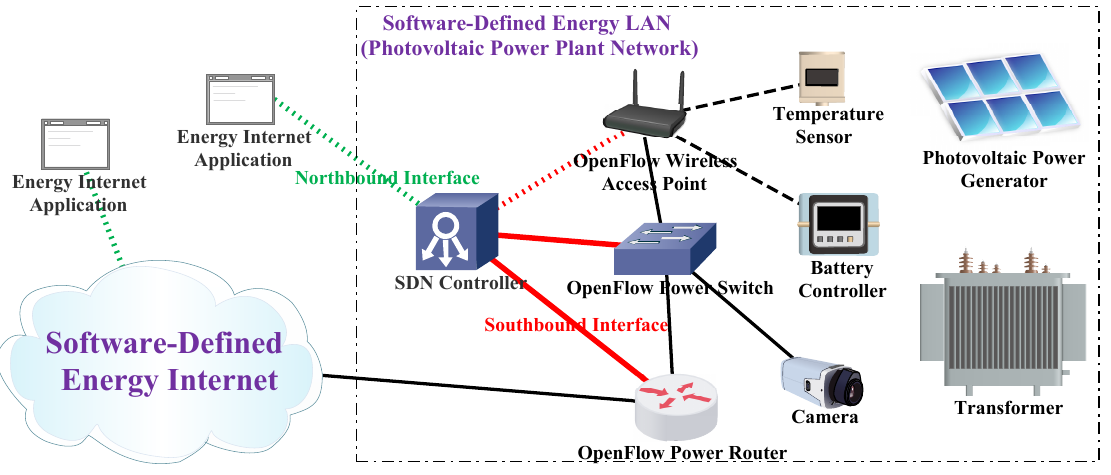
Figure 1. Software-defined energy